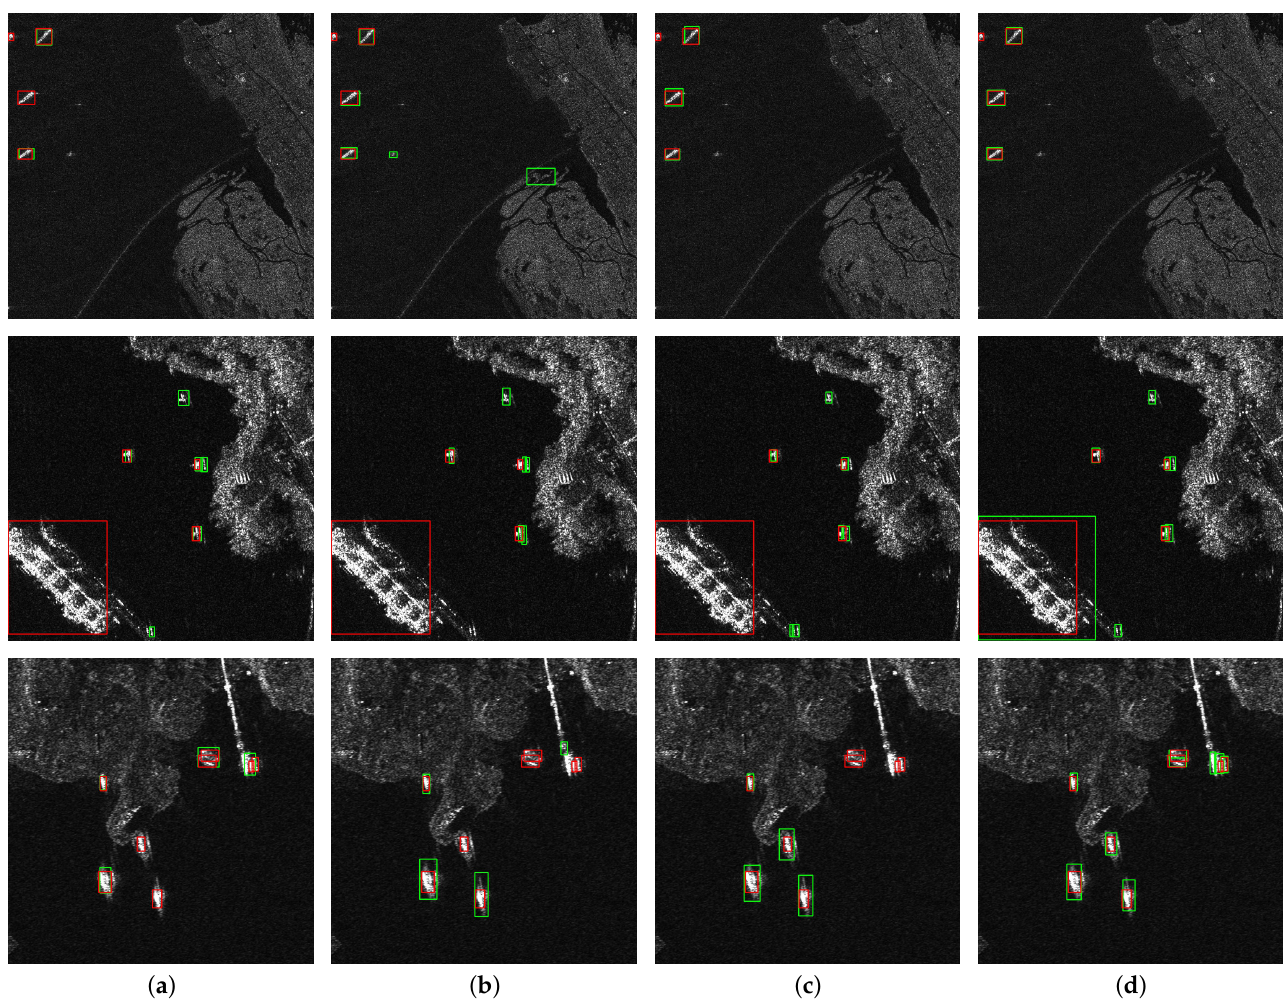
Figure 7. Comparison of detection effects. The red bounding box denotes ground-truth and the green bounding box denotes predicted results. ( a ) Faster R-CNN. ( b ) Faster R-CNN w/ Image-level alignment. ( c ) Faster R-CNN w/ image-level alignment and convolution-level alignment. ( d ) MAN